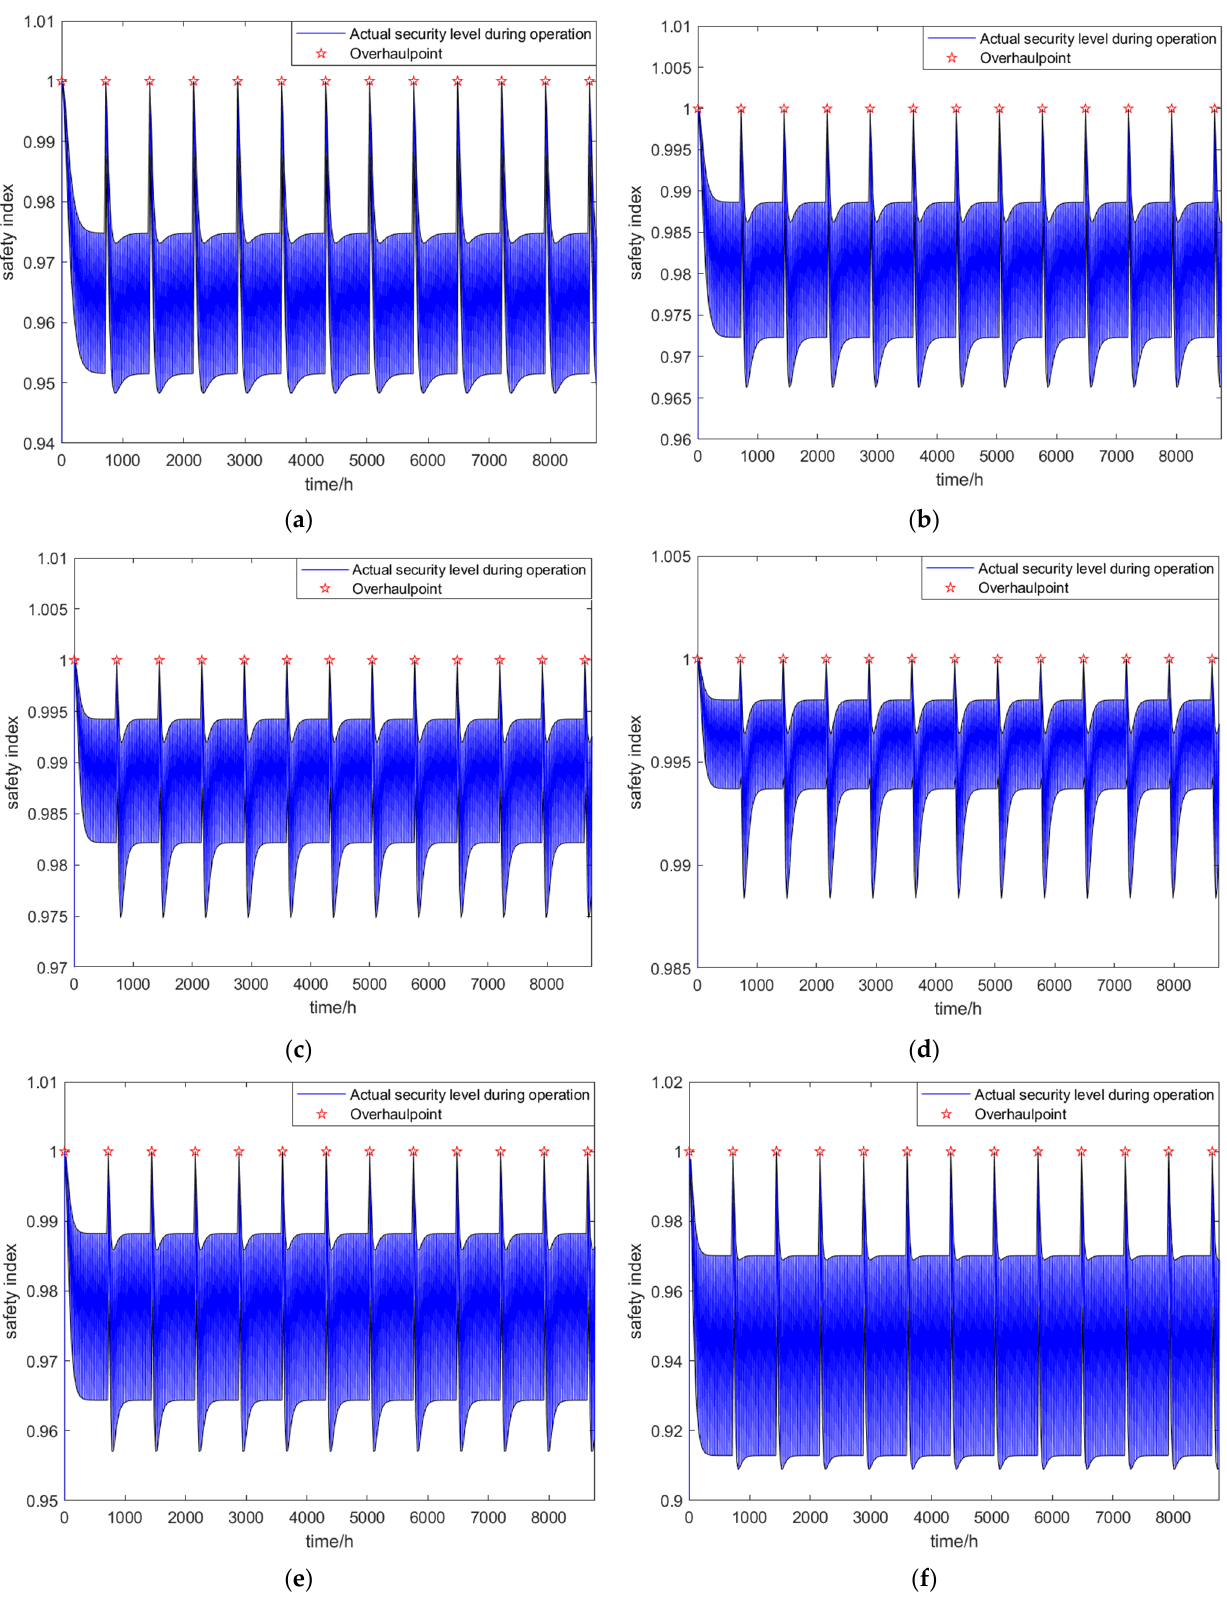
Figure 8. Safety index comparison under different failure rates and different daily maintenance rates: ( a ) safety index in μ = 0.03 and λ = 0.003; ( b ) safety index in μ = 0.04 and λ = 0.003; ( c ) safety index in μ = 0.05 and λ = 0.003; ( d ) safety index in μ = 0.05 and λ = 0.002; ( e ) safety index in μ = 0.05 and λ = 0.004; and ( f ) safety index in μ = 0.05 and λ = 0.006.